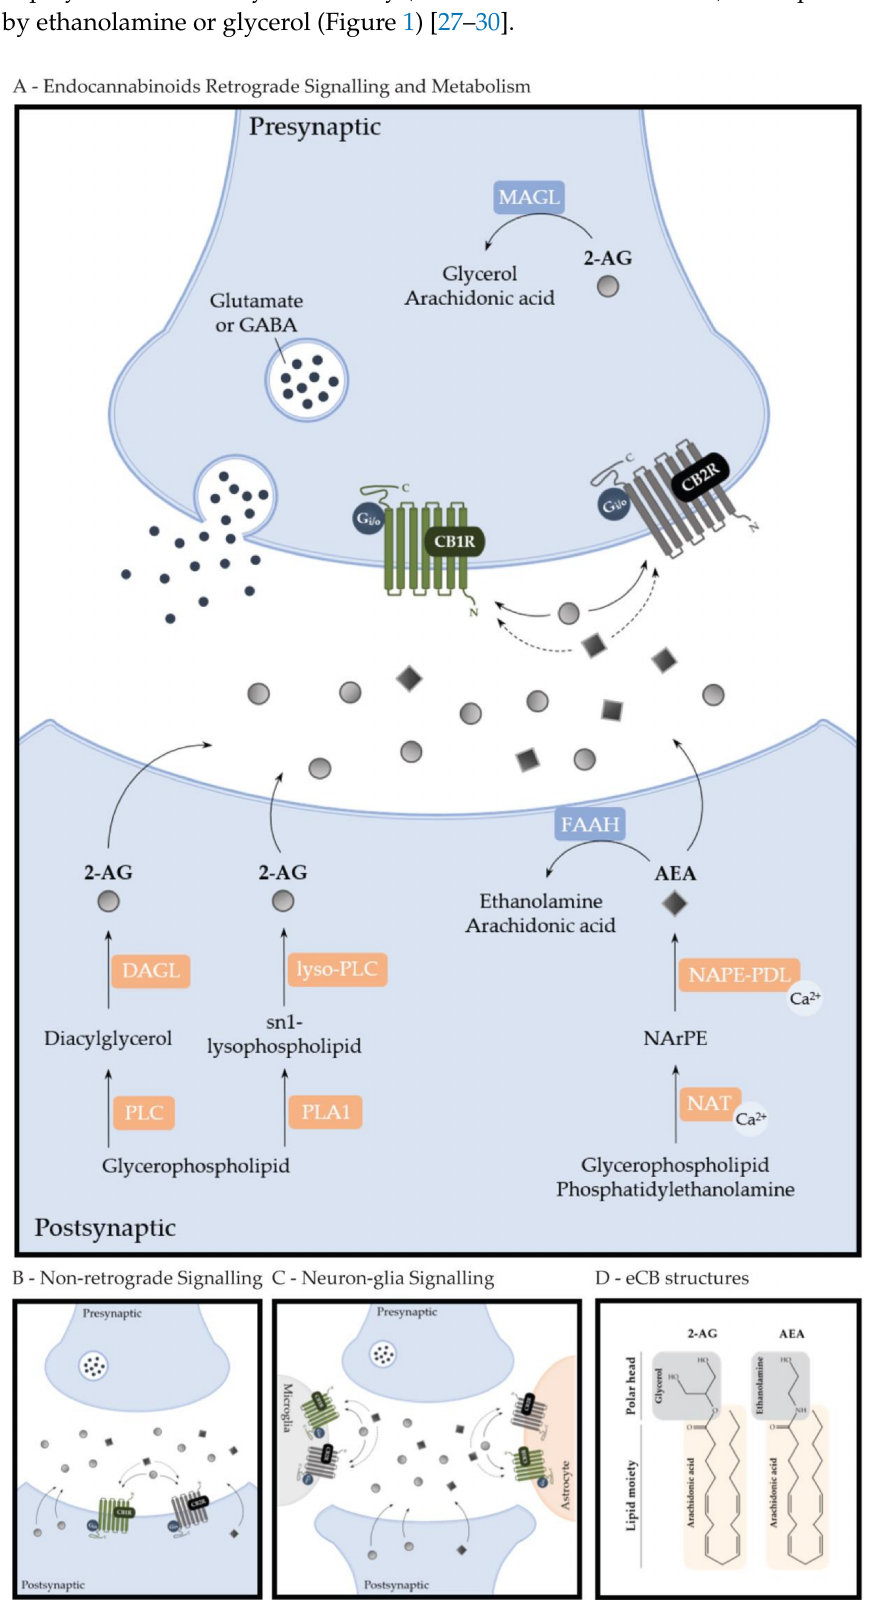
Figure 1. Endocannabinoid signaling. ( A ) Endocannabinoid Retrograde Signaling and